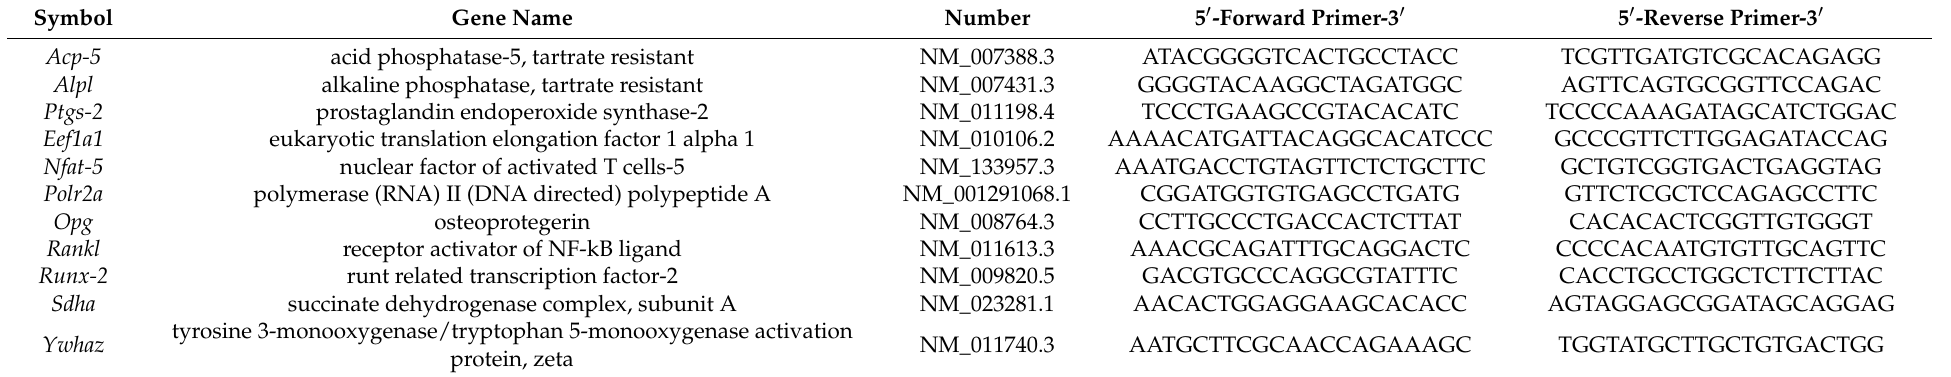
Table 1. Sequences of used reference and target genes. The combination of Eefa1a/Ywhaz was used for Figure 2. Sdha/Ywhaz was used for osteoclast-derived